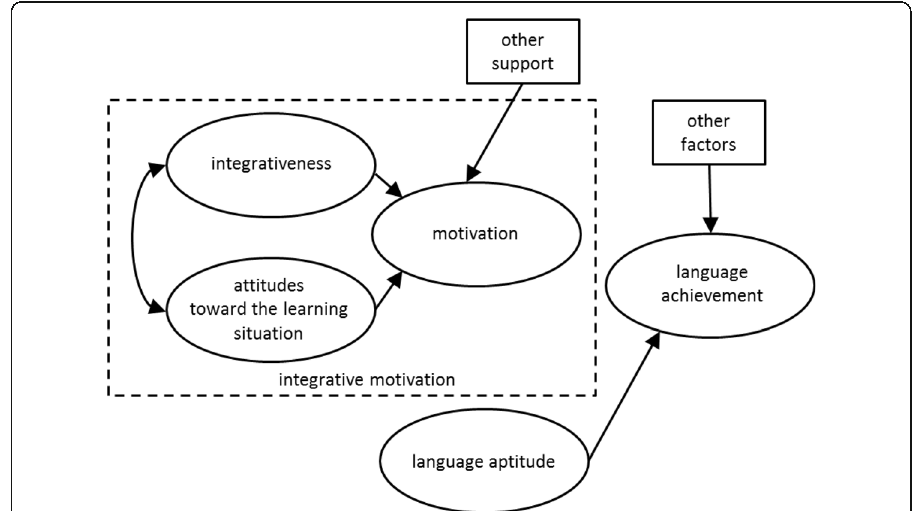
Fig. 1 Socio-Educational Model of Second Language Acquisition (Gardner